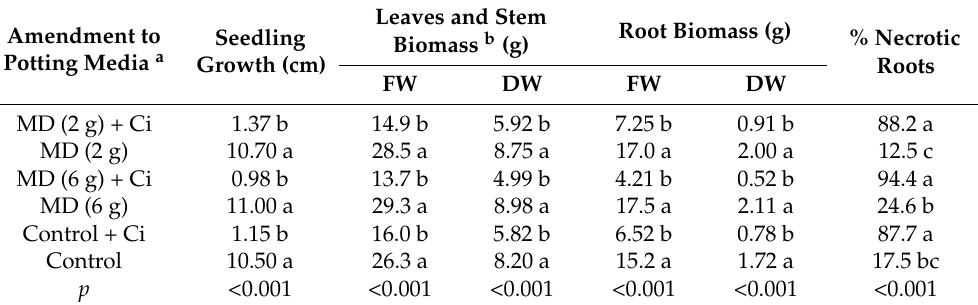
Table 8. Seedling growth, fresh and dry weight of avocado leaves and stems and roots and percent of necrotic roots after amendment of potting mix with Mineral Dust (MD) and inoculation with Calonectria ilicicola (Ci), Experiment